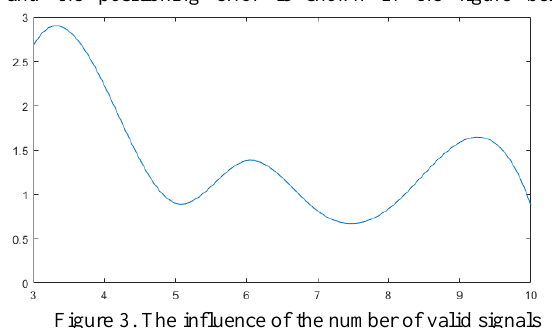
Figure 3. The influence of the number of valid signals